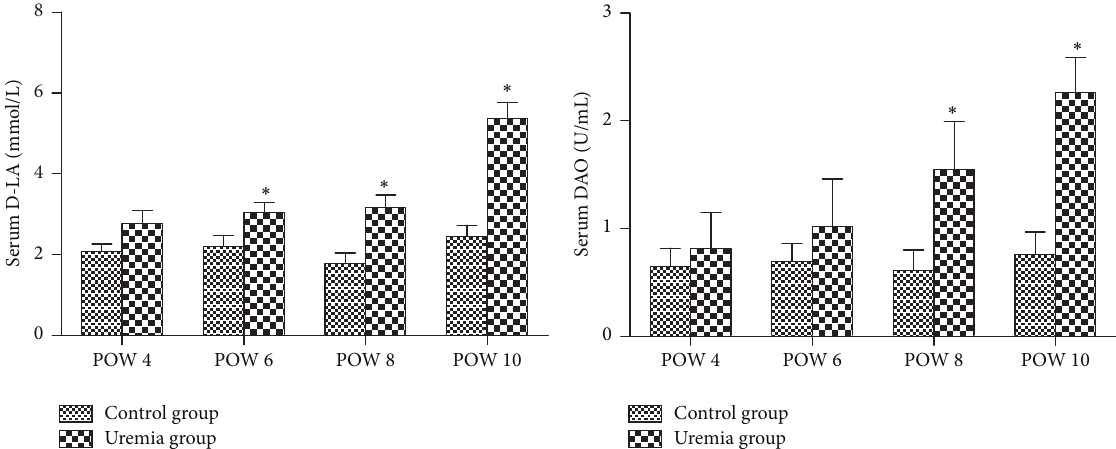
Figure 3: Serum LA levels and DAO activity in each group. POW: postoperative week. Data are expressed as mean ± SD. ∗ 𝑃 < 0.05 , versus control group at the same time